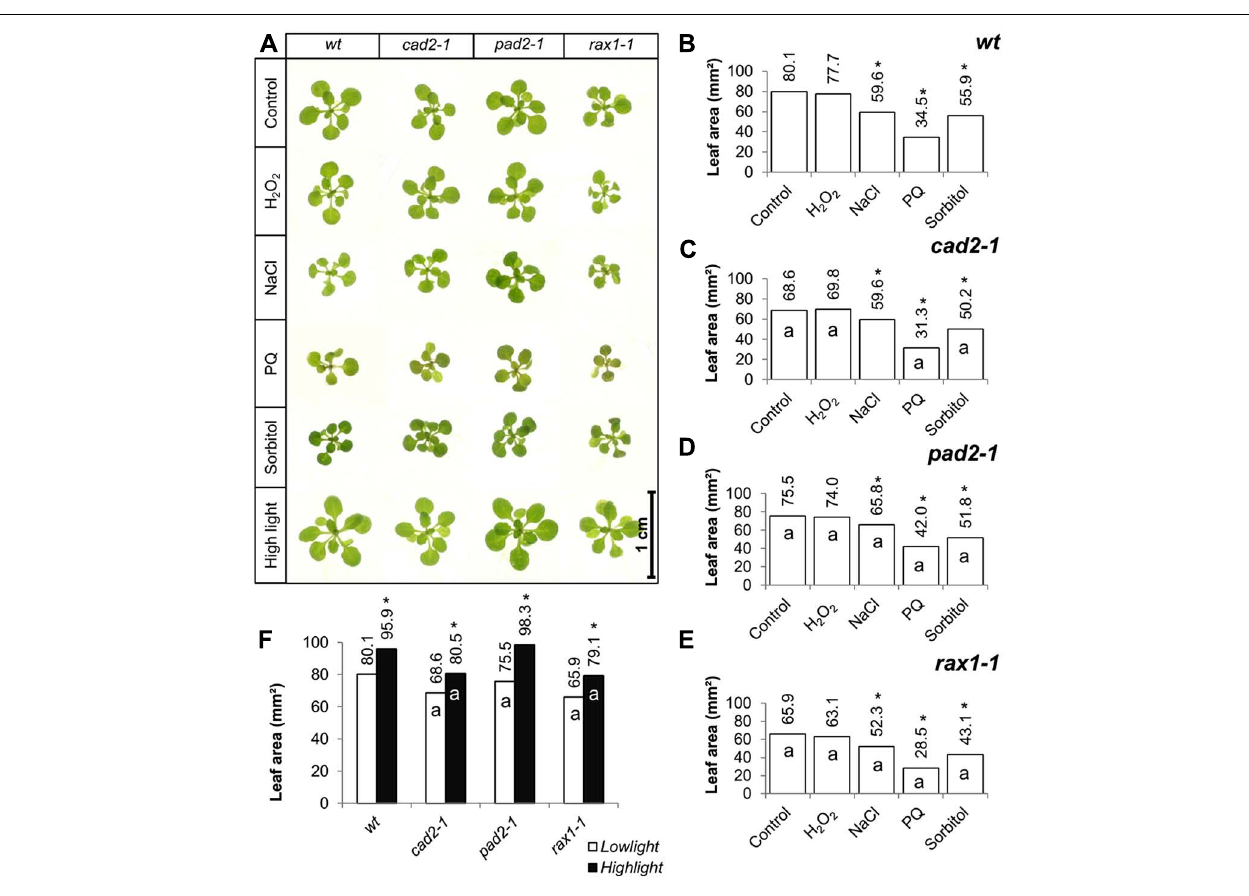
FIGURE 2 |A comparison of the effects of short-term (4 days) exposures to different abiotic stresses treatments on rosette leaf area in the rax1-1 , cad2 -1 , and pad2-1 mutants relative to wild type, Col-0 (wt). In all cases seedlings were grown for 10 days under optimal conditions and then transferred to different abiotic stress treatments for a further 4 days. Phenotypes (A) and leaf area (B–F) of seedlings measured at 14 days either in the absence (control) or presence of the oxidative stress caused by the